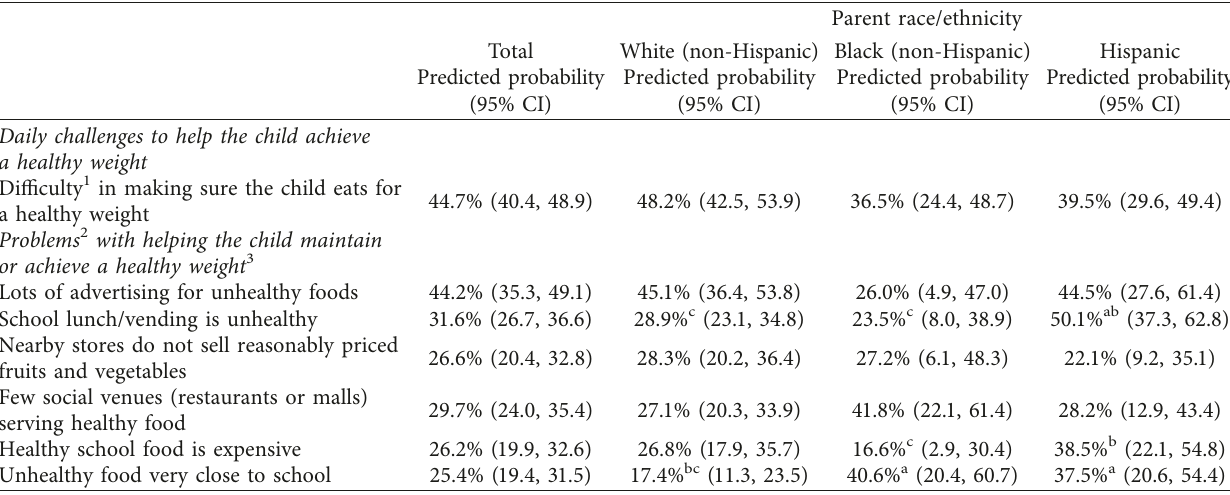
Table 2: Differences in the probability of reported overall daily challenges in helping their children eat to maintain or achieve a healthy weight, by parent race/ethnicity ( n �